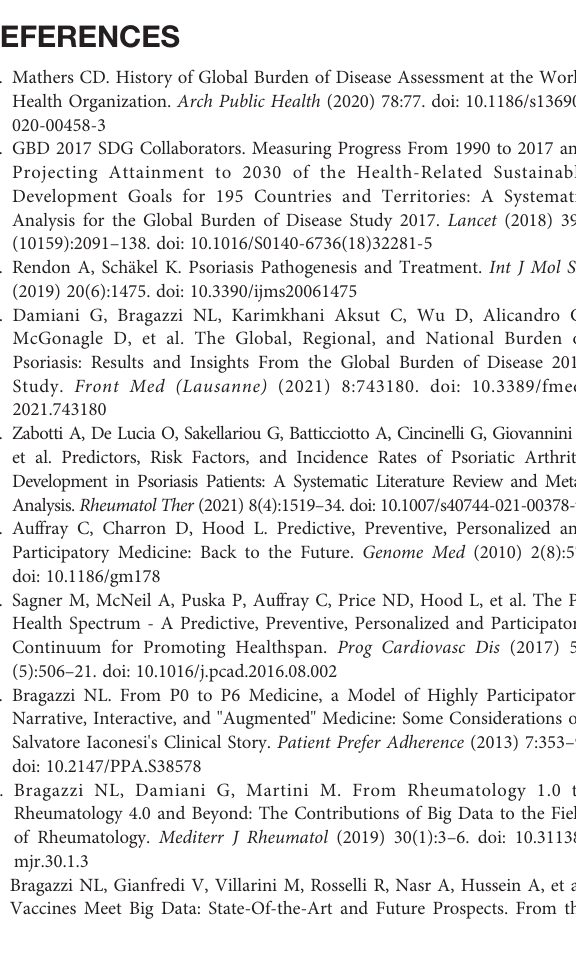
Supplementary Table 1 | Initial search literature results broken down according to each database mined.